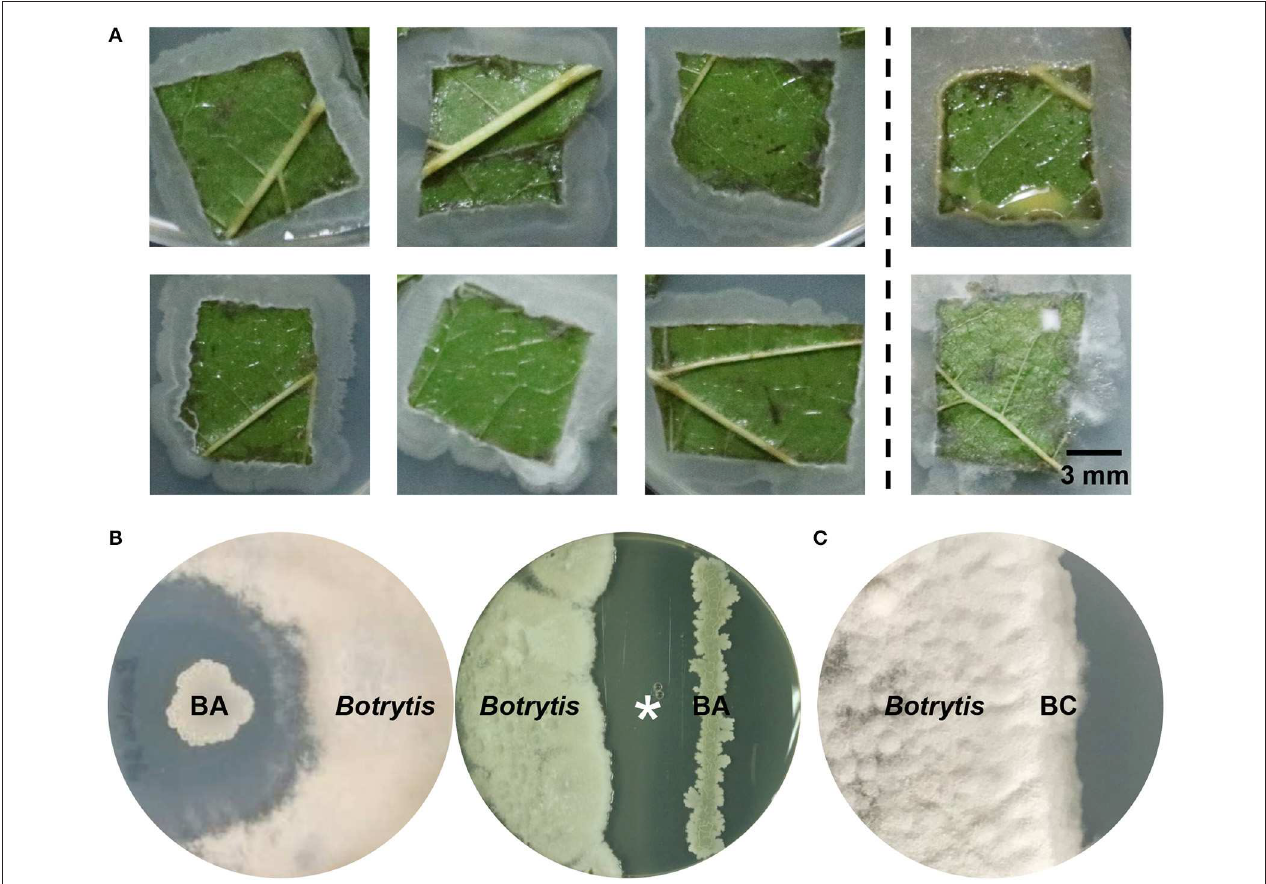
FIGURE 1 | Isolation and identification of the mulberry leaf endophytic bacterium B. amyloliquefaciens . (A) Survey of indigenous bacterial endophytes from healthy mulberry leaves. Left panel, endophytes identified as Bacillus amyloliquefaciens ; right panel, other bacterial and fungal endophytes. (B) Antagonistic effect of a newly isolated strain, B. amyloliquefaciens ZJU1 (BA), on the growth of the pathogenic fungus Botrytis cinerea . (C) The negative control Bacillus cereus (BC) did not show any antagonistic activity against B. cinerea . The asterisk indicates the competition zone extracted for the chemical detection and identification of